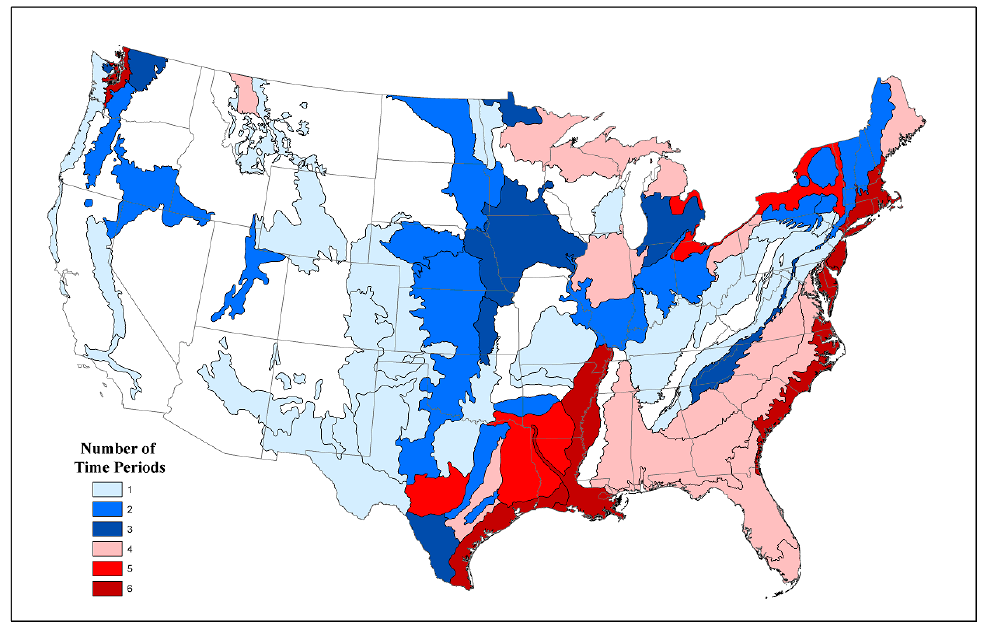
Figure 4. Ecoregions exceeding their proportion of forest in forest to urban developed land cover change in any and all time intervals. Ecoregions where the proportion of forest to developed land cover change exceeded the proportion of forest land cover found within the ecoregion. The number of ecoregions where the proportion of forest to urban developed land cover change exceeded the proportion of forest within the ecoregion every interval was far fewer (6 out of 84,) than those exceeding it occasionally and only about half the ecoregions where forest was a substantial source of new urbanization every time interval. There was less geographic clustering of the six ecoregions that exceeded their proportion of forest every interval except the three along the eastern seaboard from southern Maine through Northern Florida (Figure 4), the Mississippi Alluvial Plain and Western Gulf Coastal Plain (ecoregions #73 and #34, respectively, in Figure 1), and the Puget Lowland (ecoregion #2 in Figure 1) in the Pacific Northwest. The six ecoregions that exceeded their forests’ proportions when converting to urban development generally did so substantially. Even though the annual rate of forest to developed land cover change was set at a fairly conservative number of 0.2%, only a minority of the ecoregions (12 out of 84) met or exceeded this rate at any time during the study period. Geographically, four clusters and one additional ecoregion are visible (Figure 5) although several of the clusters merge to create even larger contiguous regions. greater annual change of upland forest converting to urban developed land cover at least once during the study period. Inland, the Northern Piedmont (ecoregion #64 in Figure 1) links highly urbanized areas of the Northeast coastal ecoregions and the Piedmont (ecoregion #45 in Figure 1) cities along the Fall Line and the foothills of the Appalachian Mountains, Gottmann’s older “Megalopolis” of interspersed mosaics of urban, forest, and agricultural land covers [55] meeting up with Hart’s and Morgan’s emerging southern “Spersopolis” of low-density, but nearly continuous, residential housing along highways linking urban centers [56]. Another cluster is centered on the Erie Drift Plains and the Eastern Corn Belt Plains (ecoregions #61 and #55 respectively in Figure 1), whereas the Puget Lowland (ecoregion #2 in Figure 1) is the only ecoregion in the Western U.S.